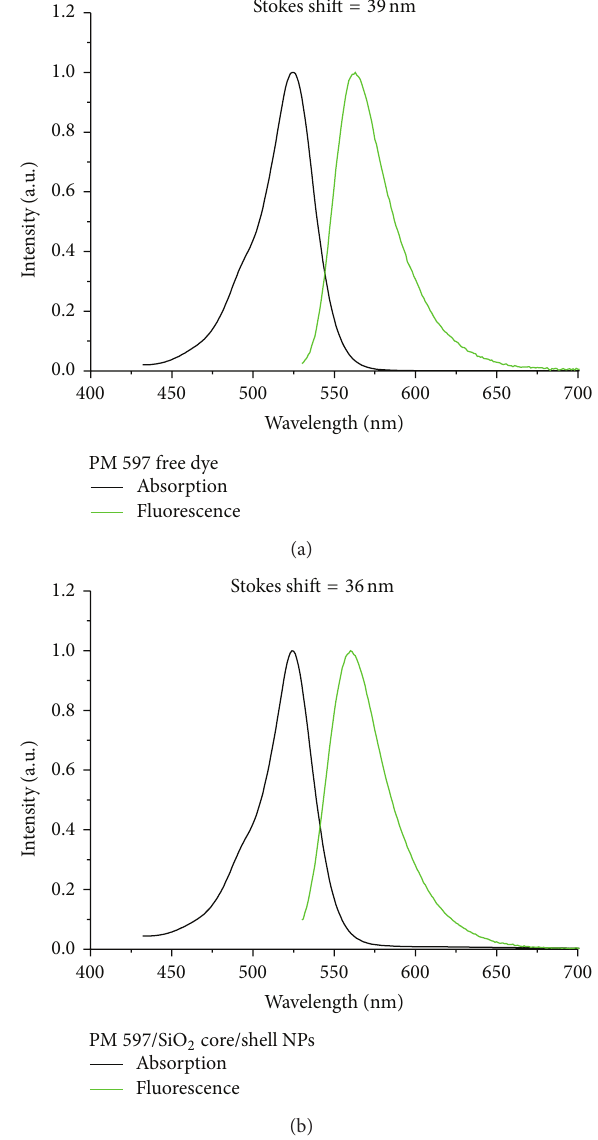
Figure 6: Stokes shifts of (a) PM 597 dye and (b) PM 597/SiO 2 core/shell